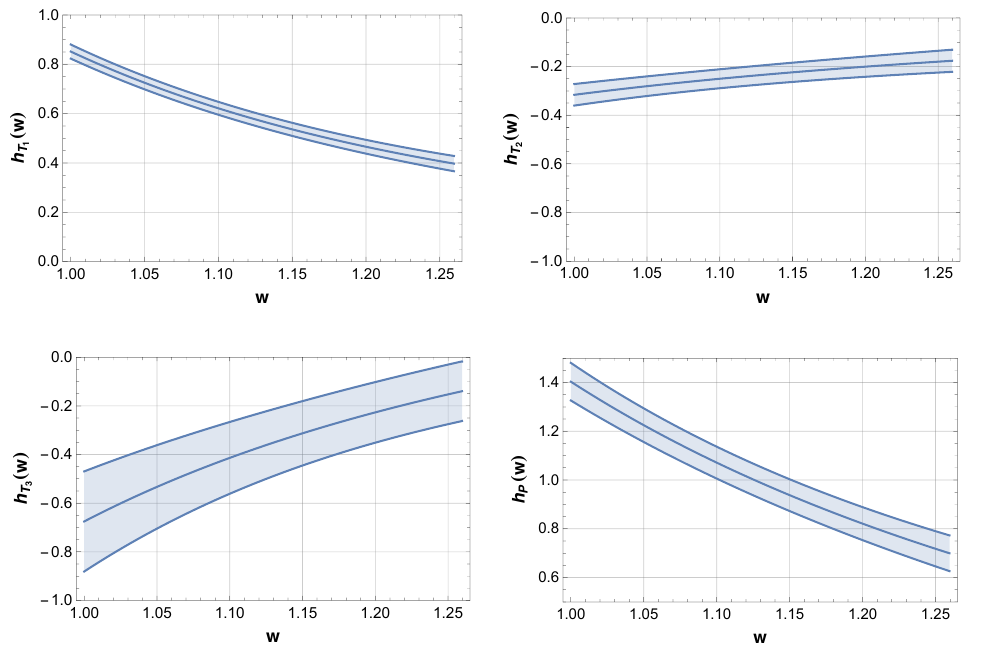
Figure 3 . Tensor B c → J/ψ form factors obtained applying eqs. (5.10), (5.11), (5.12) and (5.13) in the full kinematical range and using lattice QCD results for V and A